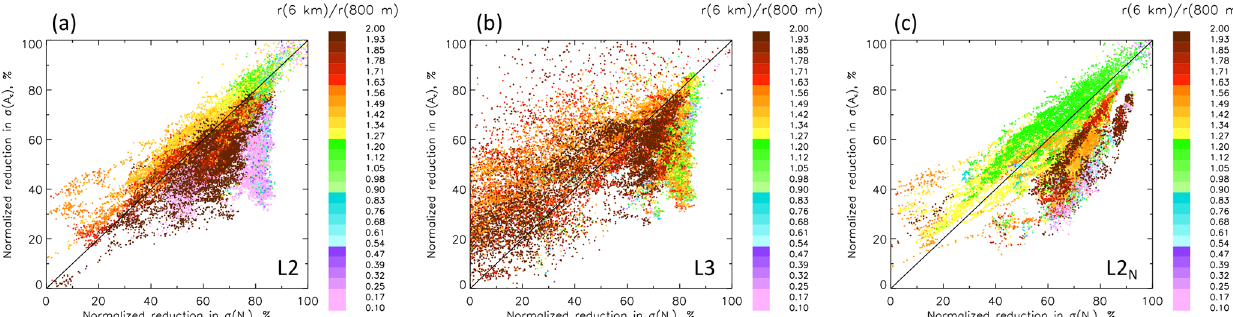
Figure 8. As in Fig. 7 but with points colored by the r ratio. See text for